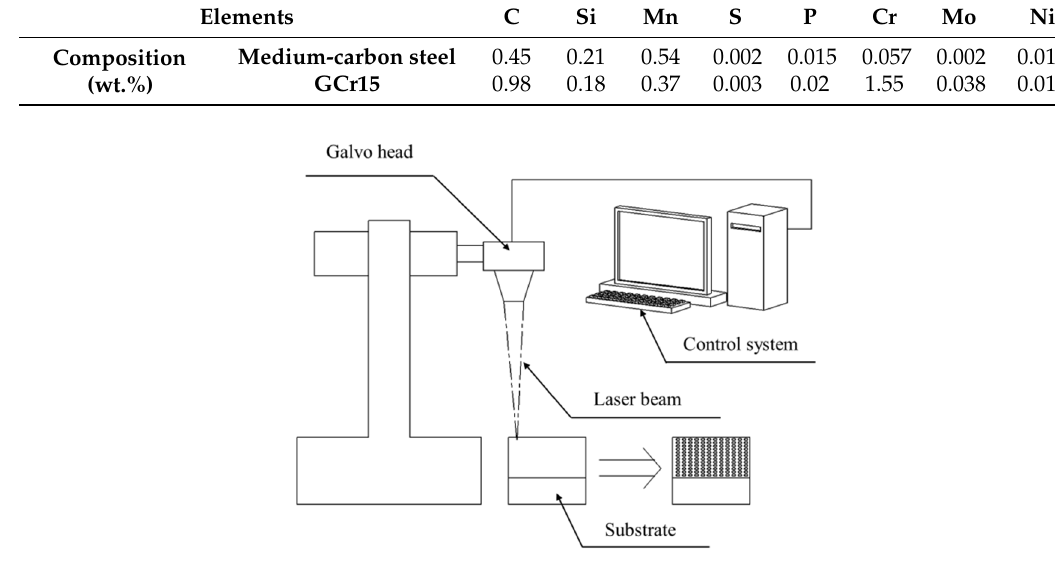
Figure 1. The experimental scheme of the laser-textured surface.